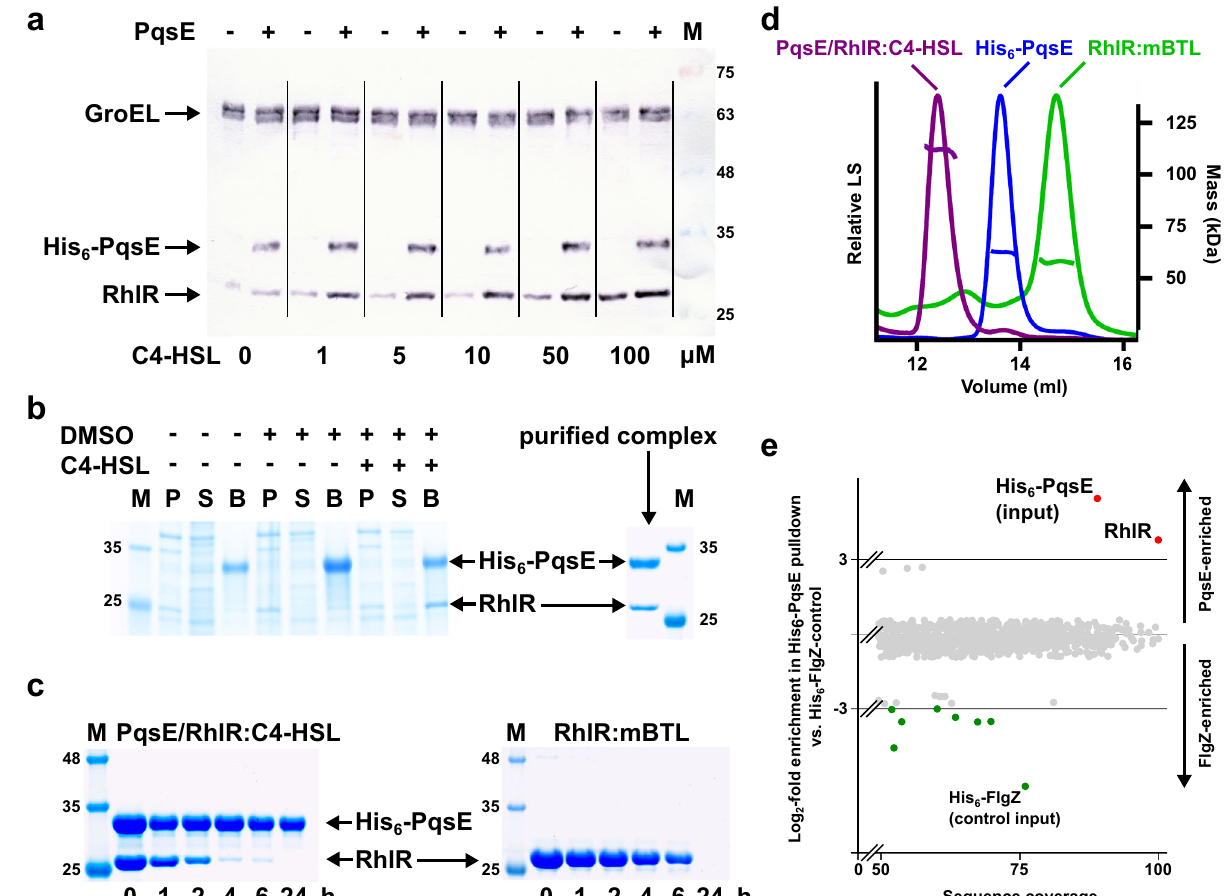
Fig. 2 | Interaction of RhlR and PqsE. a Western blot demonstrating the syner- gistic solubility-enhancing effect of C4-HSL and PqsE on RhlR. RhlR and His 6 -PqsE were expressed from plasmid vectors in E. coli BL21-CodonPlus(DE3)-RIL in the presence of the indicated concentrations of C4-HSL. Soluble extracts were ana- lyzed using GroEL as a control. The marker (M) indicates the molecular weight in kDa. A typical result from at least three independent experiments is shown. The correspondingwhole-cellextractsareshowninSupplementaryFig.1a. b SDS-PAGE of a co-expression analysis of His 6 -tagged PqsE and RhlR in E. coli BL21-Codon- Plus(DE3)-RIL.Induced cells were harvested,lysed and separated into an insoluble (P) and a soluble fraction (S), which was used to incubate Ni-NTA beads, washed and then boiledin SDS-loading buffer (B).The marker(M) indicates the molecular weight in kDa. A typical result from at least three independent experiments is shown. c Time-dependent stability analysis of PqsE/RhlR:C4-HSL and RhlR:mBTL.